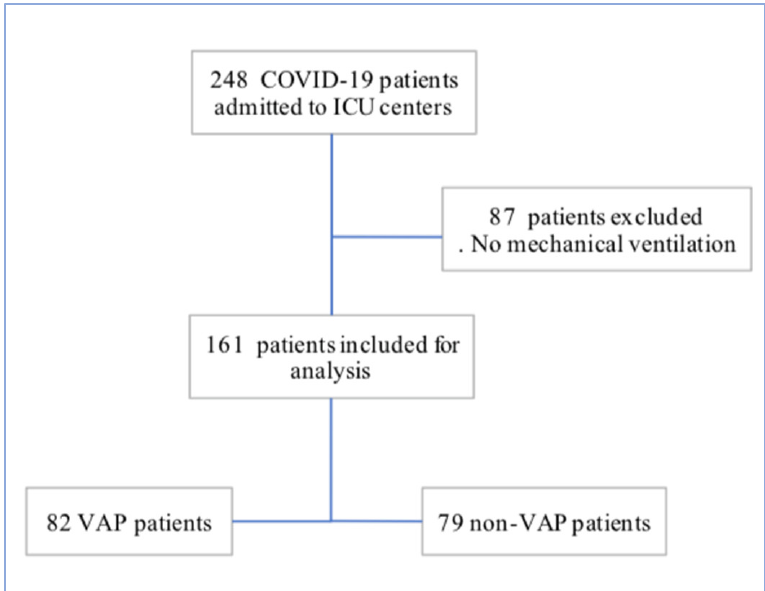
Figure 1. Study Flow chart .